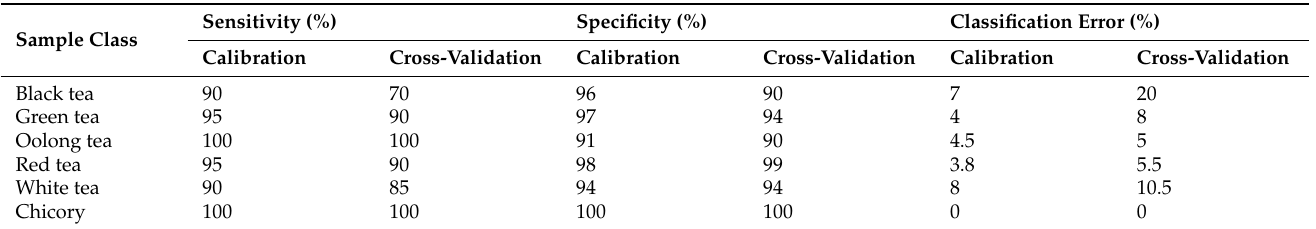
Table 1. Calibration and cross-validation multiclass predictions for the set of analyzed sample groups by